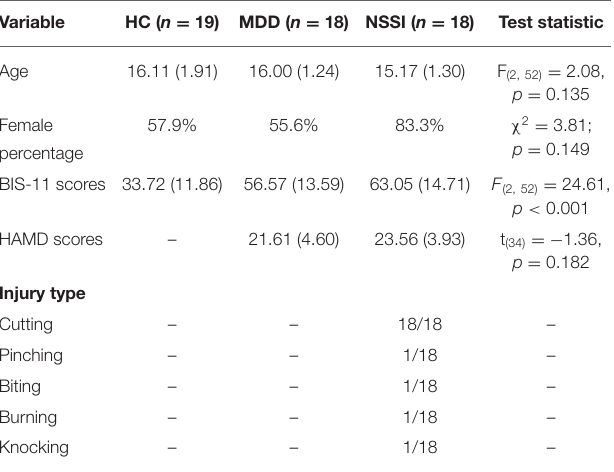
TABLE 1 | Participant characteristics of the HC, MDD, and MDD + NSSI groups.